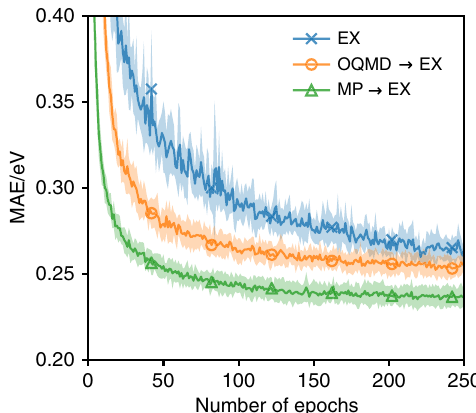
Fig. 4 Test set error during training on EX. The fi gure shows how the MAE on the test set changes throughout the training of the model for different transfer learning scenarios. The curves show the average MAE over 10 independent randomly-initialised models with the shaded area corresponding to the standard deviation of the models at